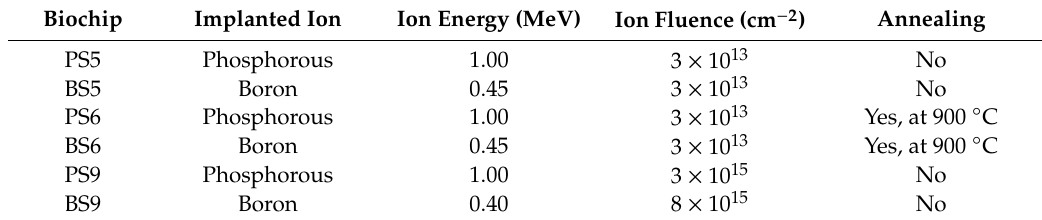
Table 1. Implantation parameters and annealing conditions of phosphor implanted (phosphorous into Si:B) and boron implanted (boron into Si:P) biochips. The Au ring top electrodes and unstructured Au bottom contacts have been prepared after ion implantation. Di ff erent ion species together with ion energy, ion fluence, and annealing conditions have been applied when preparing the six di ff erent types of impedance